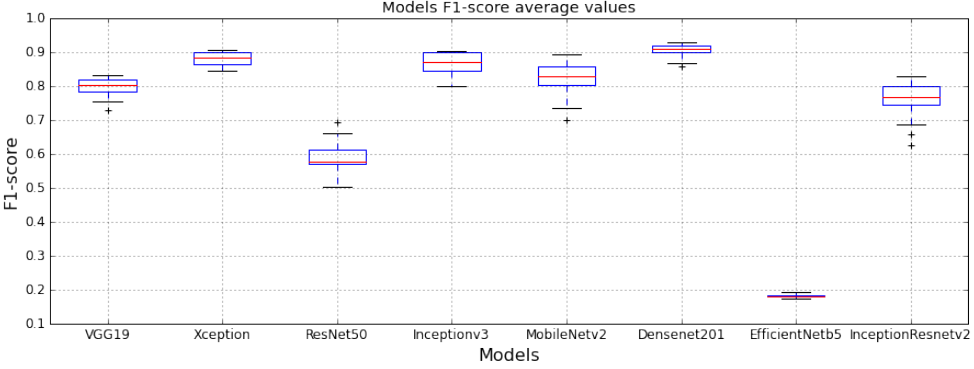
Figure 4. Summary of evaluation results by pre-trained model used as a backbone, in terms of F1-score. Points marked with + represent outliers beyond the first and third quartiles.